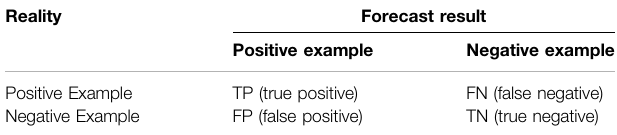
TABLE 3 | Confusion